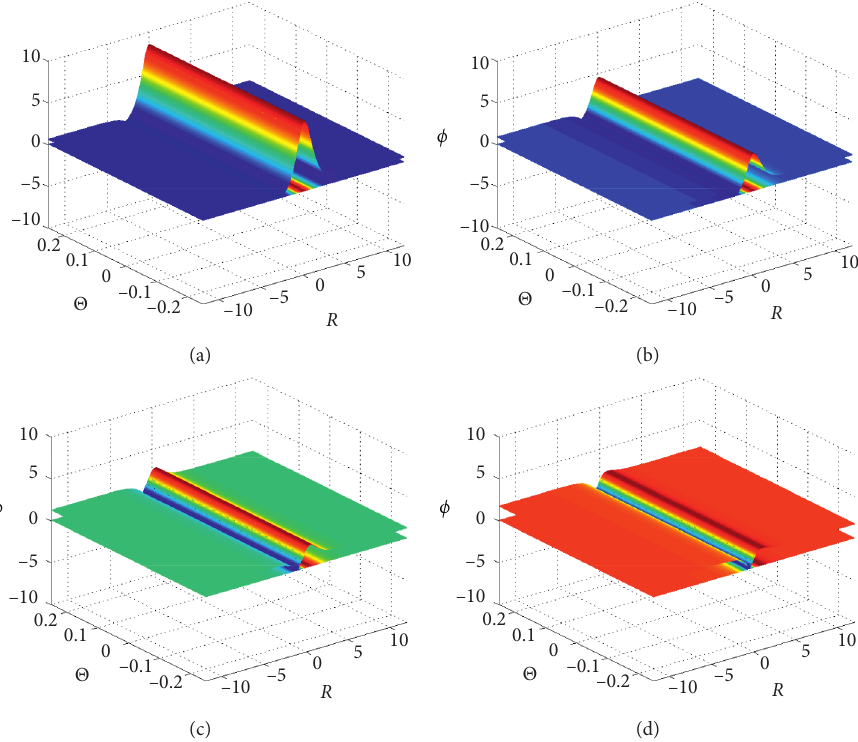
� 1 . 2, β � 1 . 6, ω � 1, and ϖ � 1. (c) 1 3